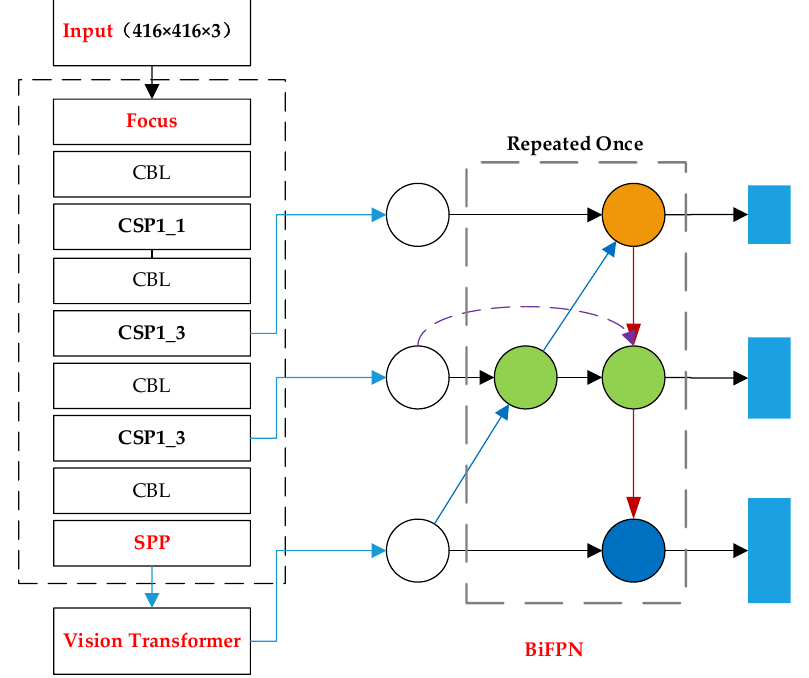
Figure 11. The improved network architecture for YOLOv5s-ViT-BiFPN. The Vision Transformer is inserted behind the Backbone. The PANet is replaced by BiFPN to fuse the multi-scale features and, in this study, only repeated once for efficiency. The blue box is the outputs for different scales.